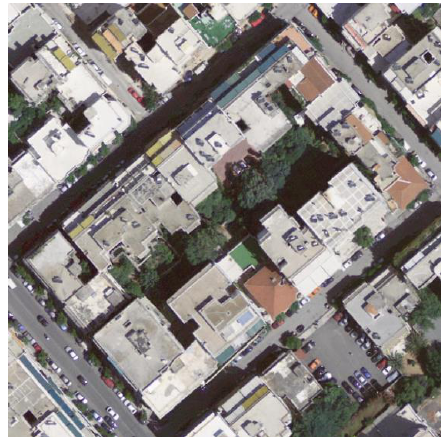
Fig. 4 Test area binary mask.